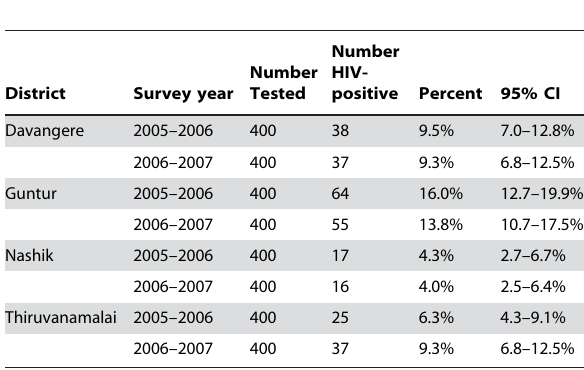
Table 2. Trends in HIV seroprevalence among tuberculosis patients in 4 districts, 2005–6 survey and 2006–7 surveys.